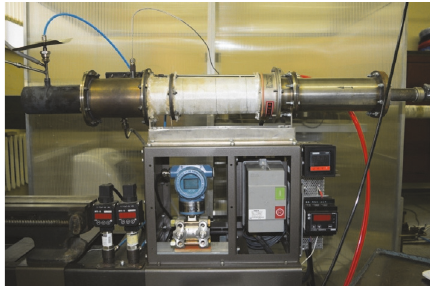
Figure 2: General view of the high-temperature setup.